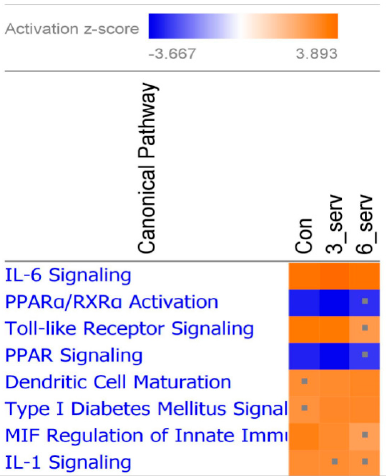
Figure 1. Canonical pathways constructed from differentially expressed genes induced in alveolar macrophages after Lipopolysaccharide (LPS) stimulation. Heatmap displays the top significant canonical pathways affected by dietary interventions. The orange and blue colored squares indicated predicted pathway activation or predicted inhibition, respectively, using a z -score threshold of 3.0. The significance indicates the probability of association of molecules from the dataset with the canonical pathway by random chance. Represents pathways with z -score less than 3.0. Nutrients 2018 , 10 , x FOR PEER REVIEW